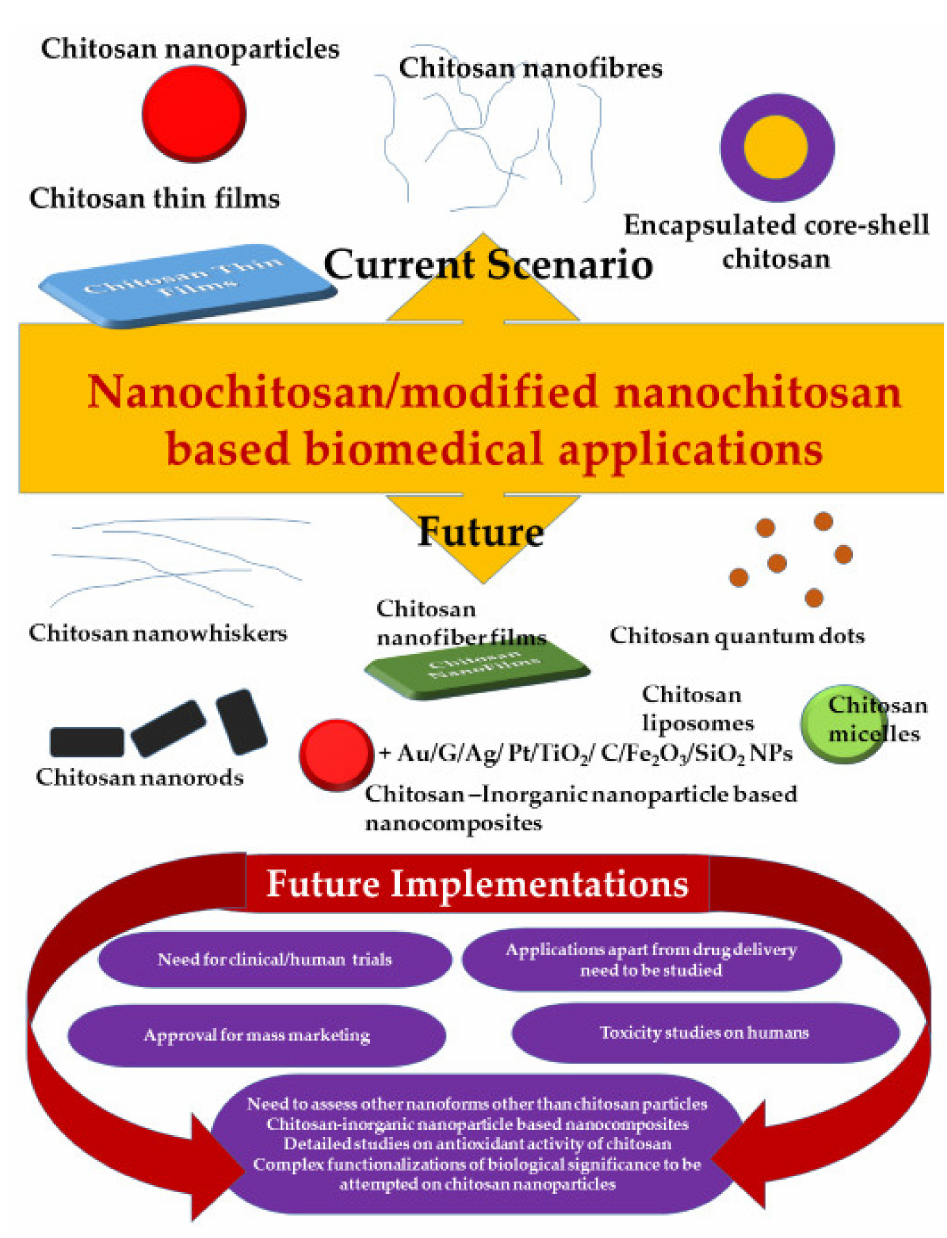
Figure 3. Future of chitosan nanomaterial based biomedical